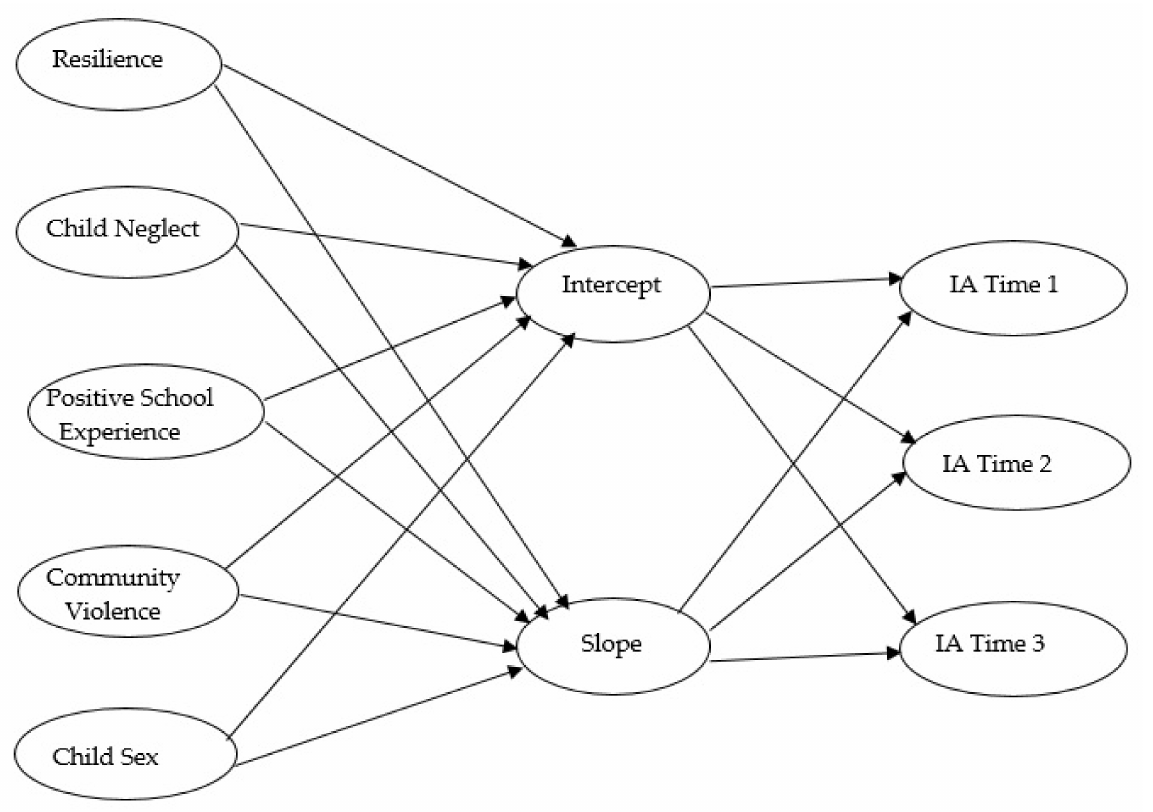
Figure 1. Hypothesized Research Model. Note. IA = internet addiction. Time 1 and Time 2 are two years apart. Time 2 and Time 3 are 2 years